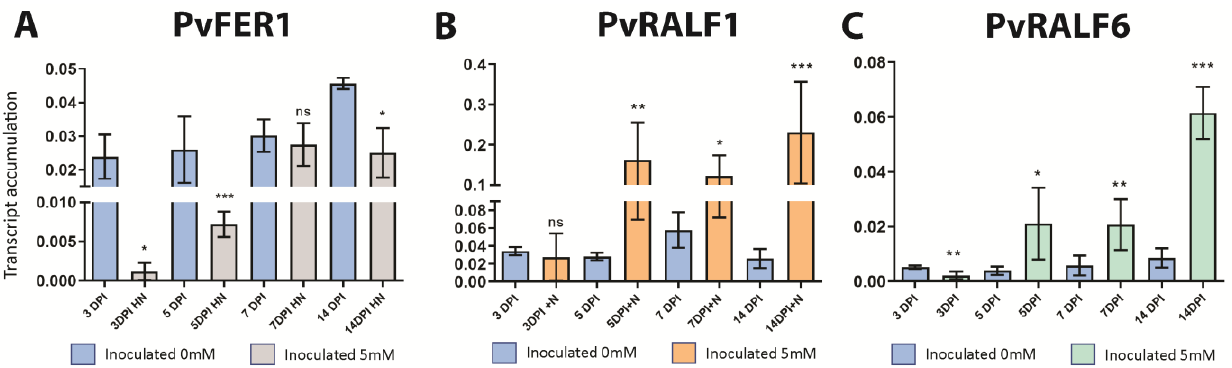
Figure 5. PvFER1 , PvRALF1, and PvRALF6 respond to rhizobial inoculation in roots at 5 mM. ( A – C ) Accumulation levels of PvFER1 (gray bars, A ), PvRALF1 (orange bars, B ), and PvRALF6 (green bars, C ) transcripts in roots inoculated in low (blue bars) and high nitrate. Data are means ± SD ( n ≥ 9). A non-parametric Mann – Whitney test was used to assess significant differences. * p < 0.05, ** p < 0.01, *** p < 0.001; ns = not significant. The transcript accumulation of the IDE gene was used as a refer- ence.